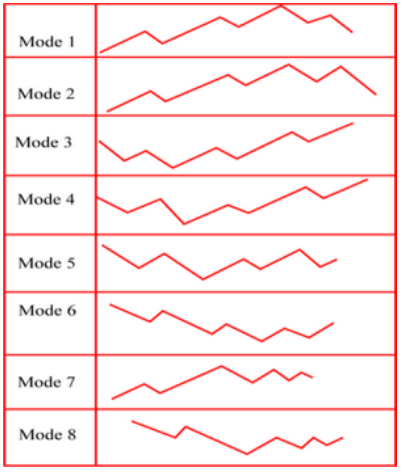
Figure 8. Elliott wave basic